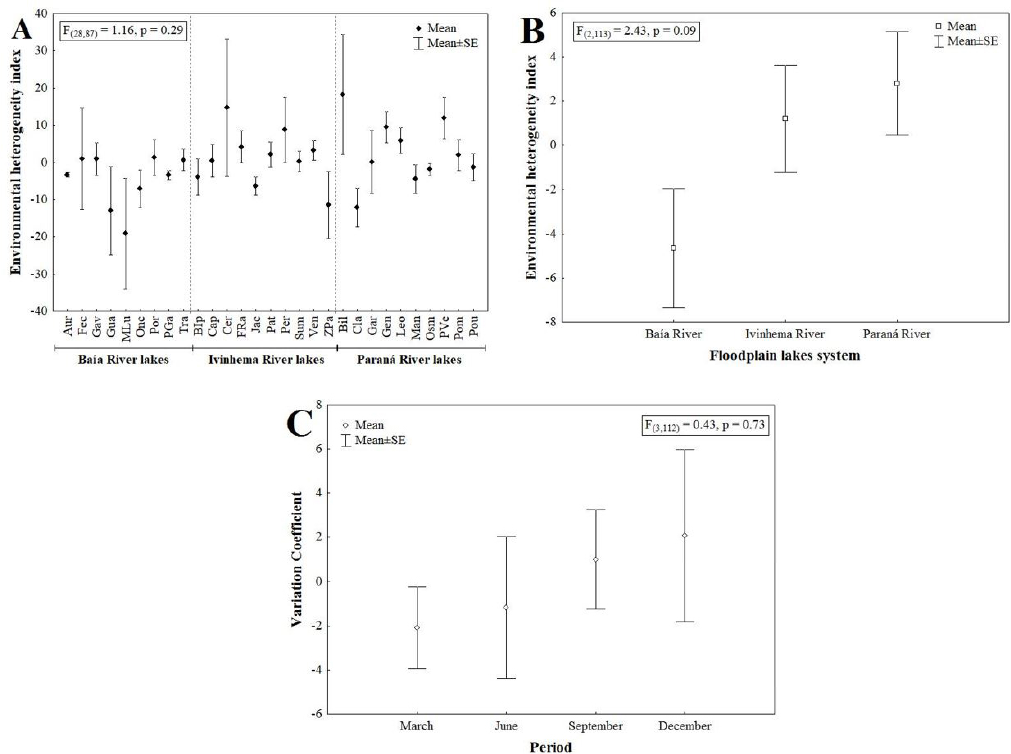
Figure 3. Coefficient of variation values according to the mean and standard error (SE) of (A) each floodplain lakes; (B) floodplain lakes system; and (C) periods. Please vide Figure 1 for lakes name